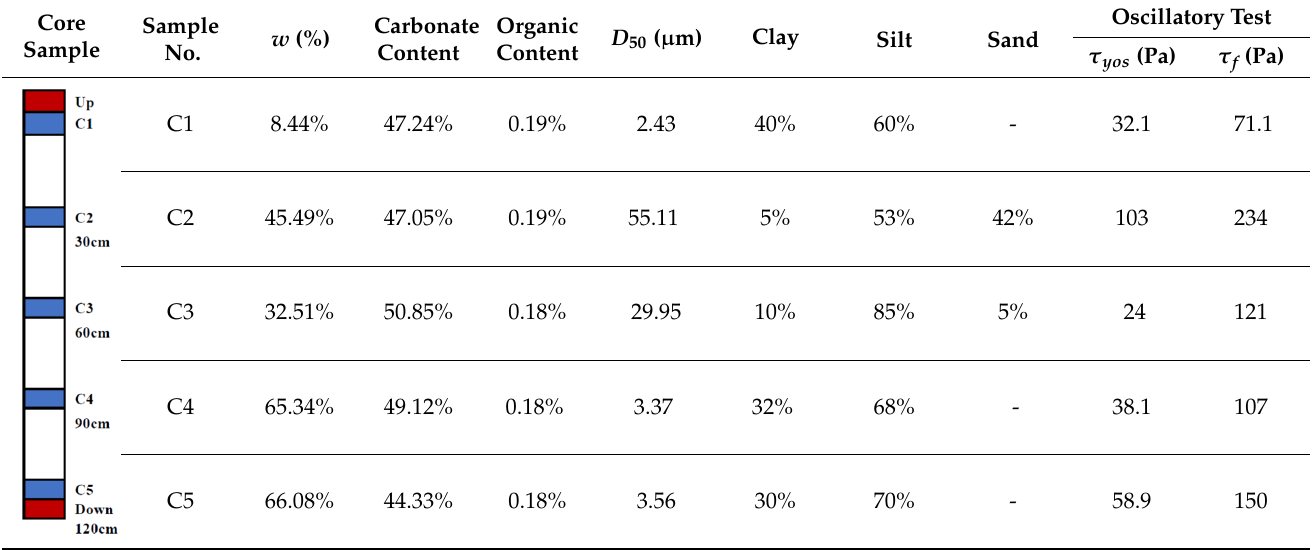
Table 7. Properties of sub-samples from the core sediment sample.